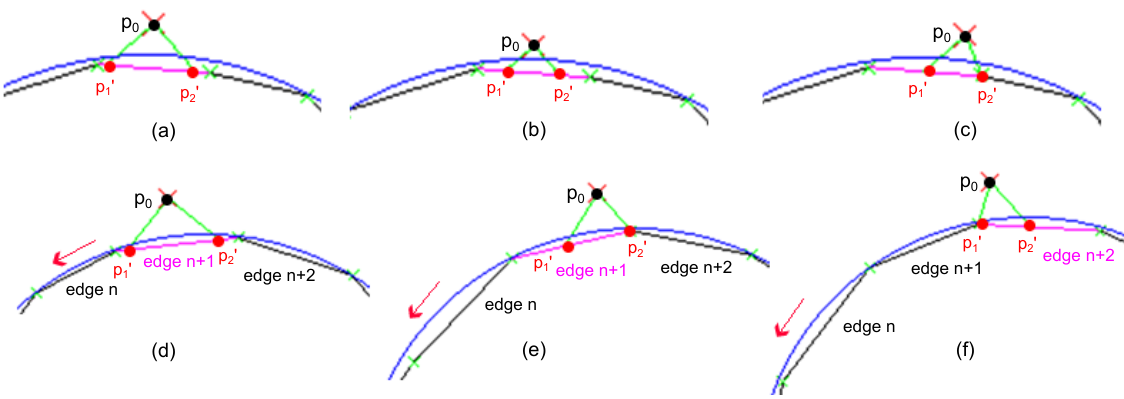
Fig. 9. (a) to (c) illustrates different relationships between the detected points and the mesh edge as well as the conic. (d) to (f) shows a slight movement of the object to the left resulting in a new correspondence between detected point and contour edge.